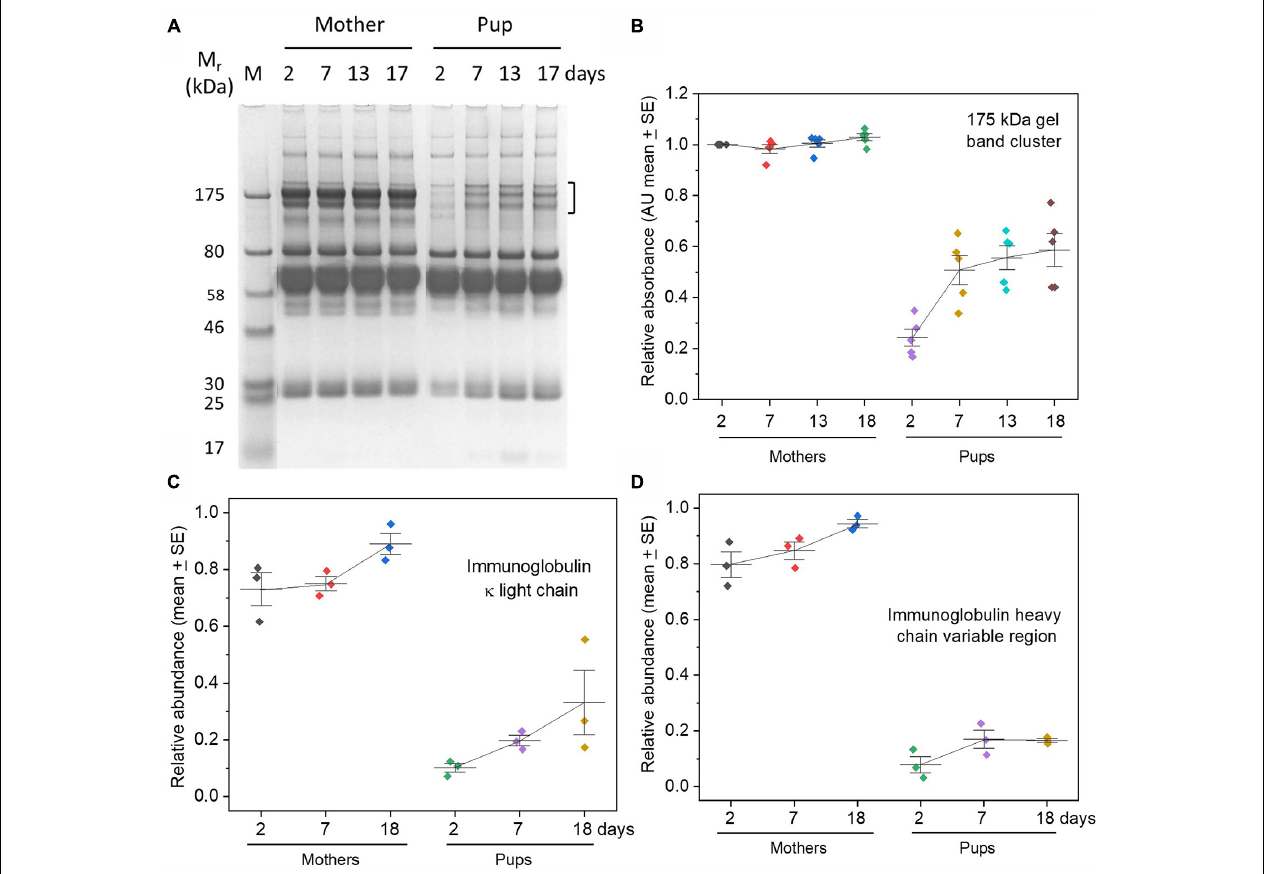
FIGURE 1 | Low levels of IgG in grey seal pup sera relative to maternal levels with only gradual accumulation by weaning time. (A) Protein electrophoresis gel of sera from one mother/pup pair (pair B) sampled on the days indicated after birth. The three closely migrating protein bands enclosed by the square bracket migrate commensurately with isotypes of IgG, accounting for size and differential glycosylation. The cluster was excised from the maternal samples in the gel and confirmed to contain IgG by proteomics (data not shown), and by reduction and re-running on protein electrophoresis gels ( Supplementary Figure 1B ). Further confidence that the 175 kDa cluster contained IgG came from proteomics of similar bands in grey seal milk (Lowe et al., 2017). M r , relative mobility of migration expressed in kiloDaltons (kDa); M, reference/marker proteins. (B) The clusters of gel bands indicated by the square bracket in (A) were optically scanned for each individual animal and optical density measurements plotted and expressed in arbitrary relative units. (C,D) Relative concentrations of immunoglobulin kappa light chain and heavy chain obtained from TMT proteomics, again indicating very low levels of immunoglobulins in pups’ sera. Similar results were obtained for lambda light chains